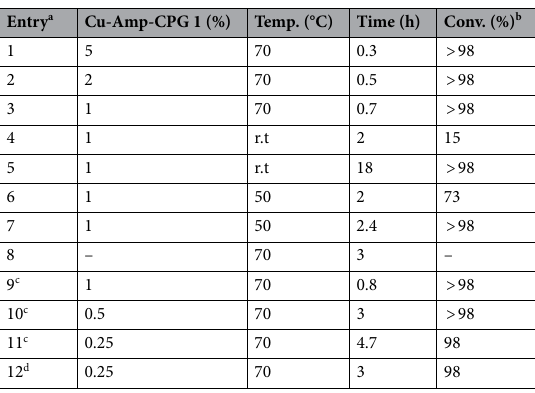
Table 1. Initial examination and model reaction of catalytic 1,3-dipolar cycloaddition of benzyl azide 2a and propargyl alcohol 3a. a